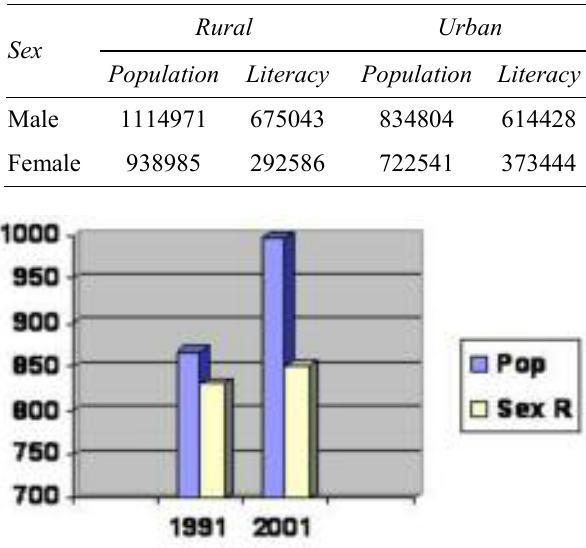
Figure 5: Population Density and Sex Ratio of Agra region Rehabilitation